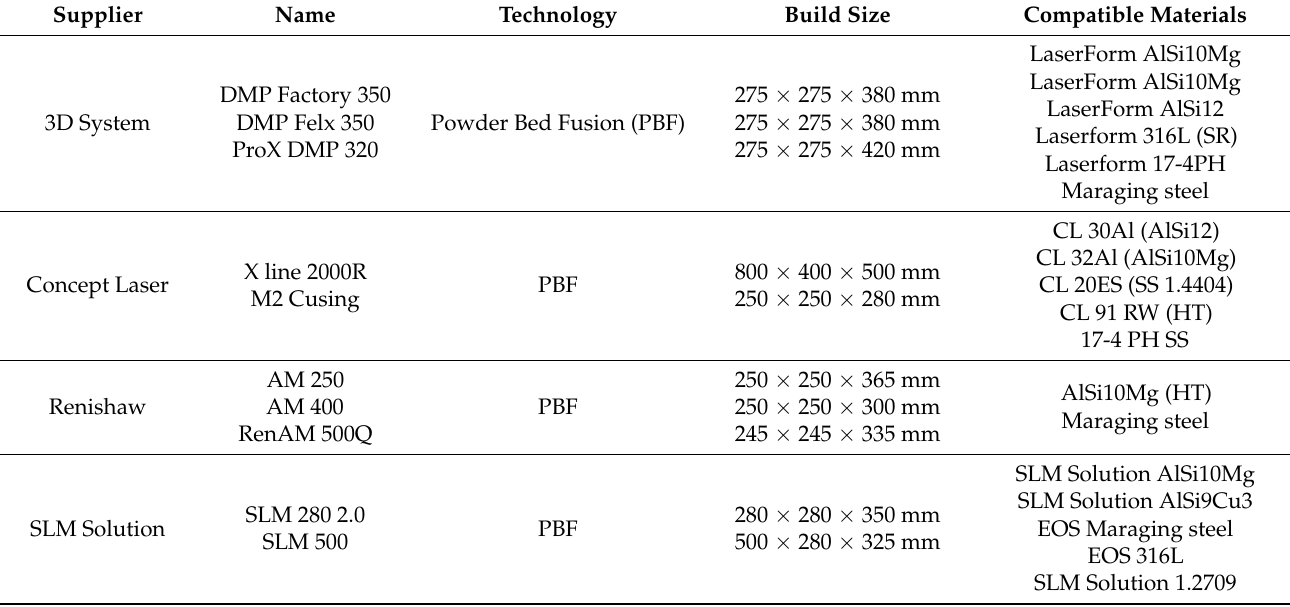
Table 12. Extract of the printer database showing the models compatible with the required part size.